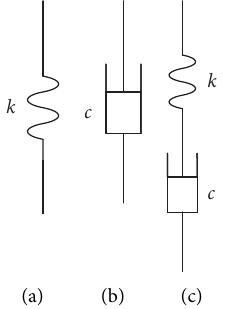
Figure 4: Simple structure after degradation: (a) TC1. (b) TC2. (c) TC3.